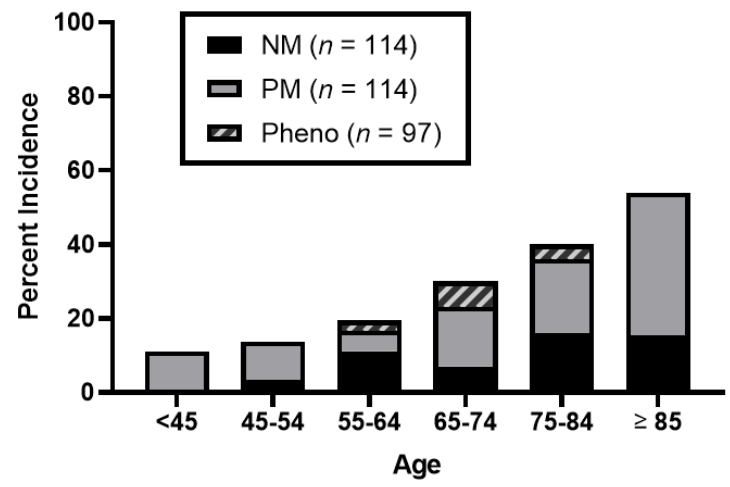
Figure 3. Incidence of bradycardia among CYP2D6 phenotypes stratified by age.